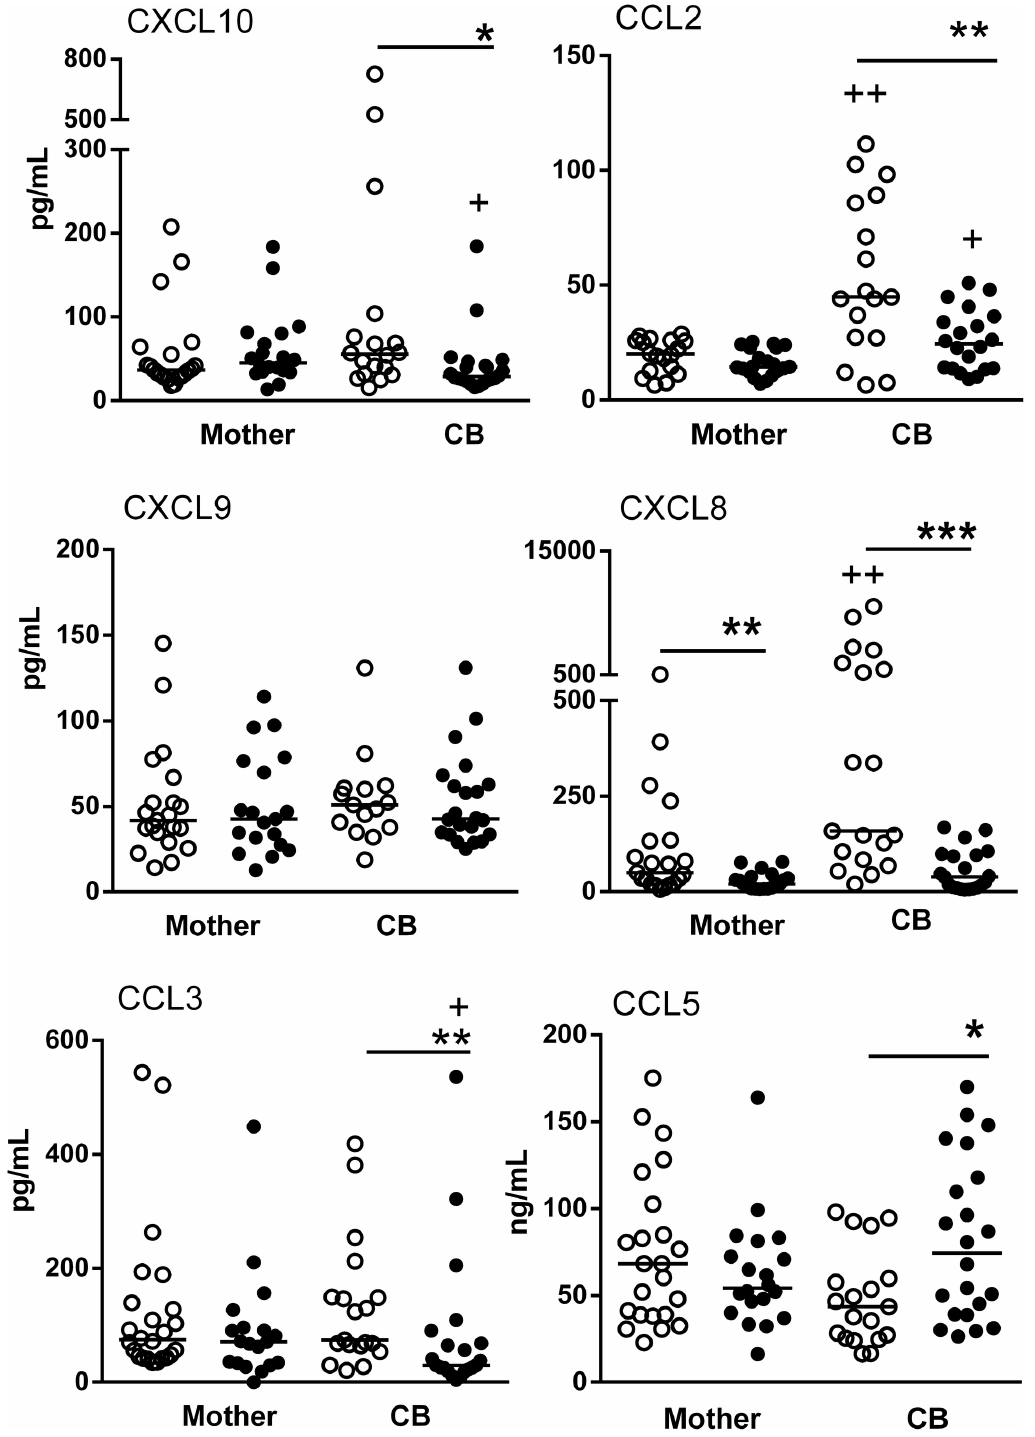
Figure 4. Altered chemokine levels in CB sera from HIV-infected mothers. Sera from HIV-infected mothers (closed symbols) and UN mothers (open symbols) (n=20-23) and their respective CB samples (n=20-23) were assessed for CXCL10, CCL2, CXCL9 and CXCL8 expression using a cytometric bead array, and CCL5 and CCL3 levels were determined by ELISA. The data represent median values. *p≤0.05, **p≤0.01, ***p<0.001 compared with the control group; +p≤0.05, ++p≤0.01 compared with the mother group. doi: 10.1371/journal.pone.0084917.g004 PLOS ONE |